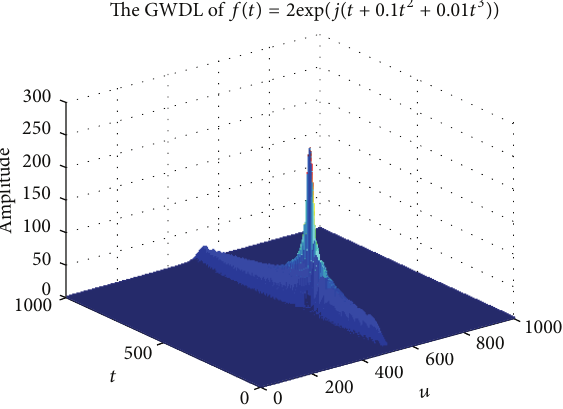
Figure 1: The GWDL of QFM signal.